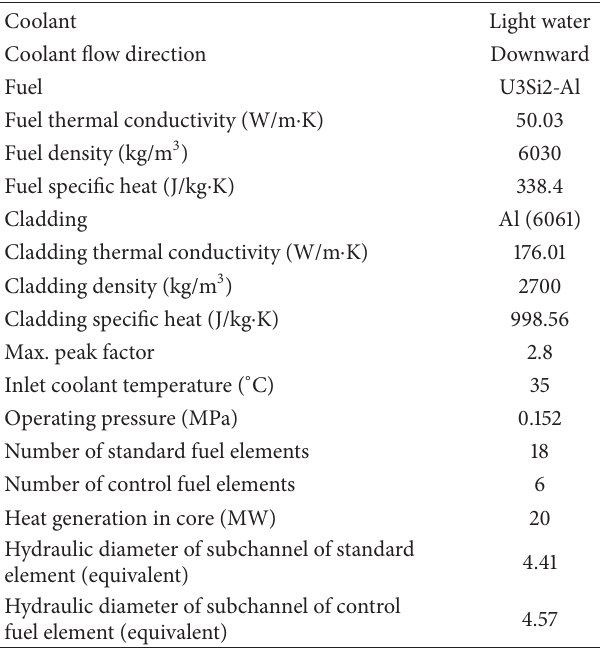
Table 1: Thermal-hydraulic parameters of the research reactor. Table 2: Boundary conditions and solving